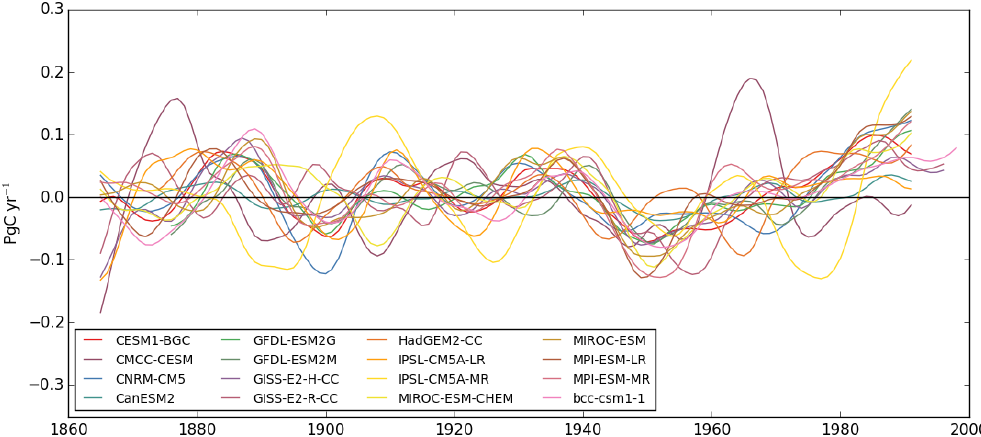
Figure 4. Variability in the global CO 2 uptake by the oceans, estimated by the group of CMIP5 climate models for the historical simulation, with prescribed atmospheric CO 2 , as well as solar radiation variability, sulfate aerosols, and volcanic eruptions. The annual values of the ocean fluxes are filtered using the same smoothing as the one applied to AGR, based on the air-age distribution for CO 2 at DE08 from Trudinger et al. (2003).